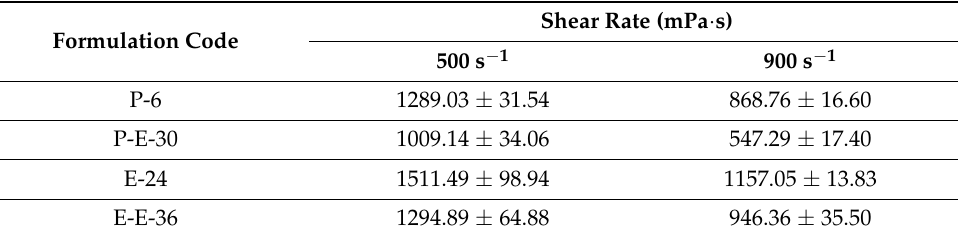
Table 5. Viscosity parameters for four benzocaine semi-solid ointments. Formulation